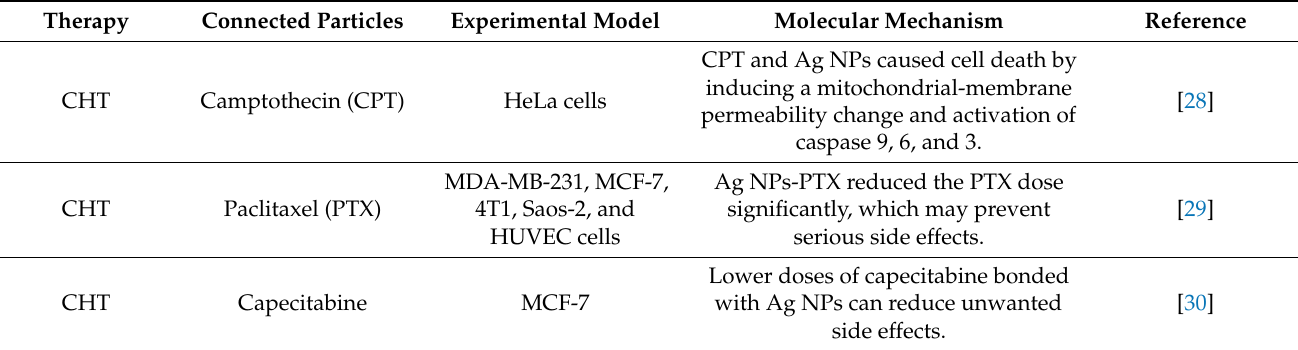
Table 2. Selected connections of biologically active molecules with silver